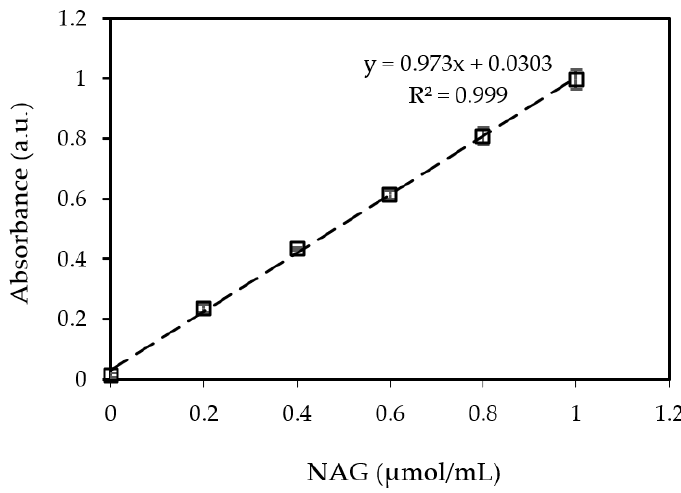
Figure A3. 13 C NMR spectra for chitin powder, chitosan powder, chitin nanocrystals (ChNC), and deacetylated chitin nanocrystals (D-ChNC).